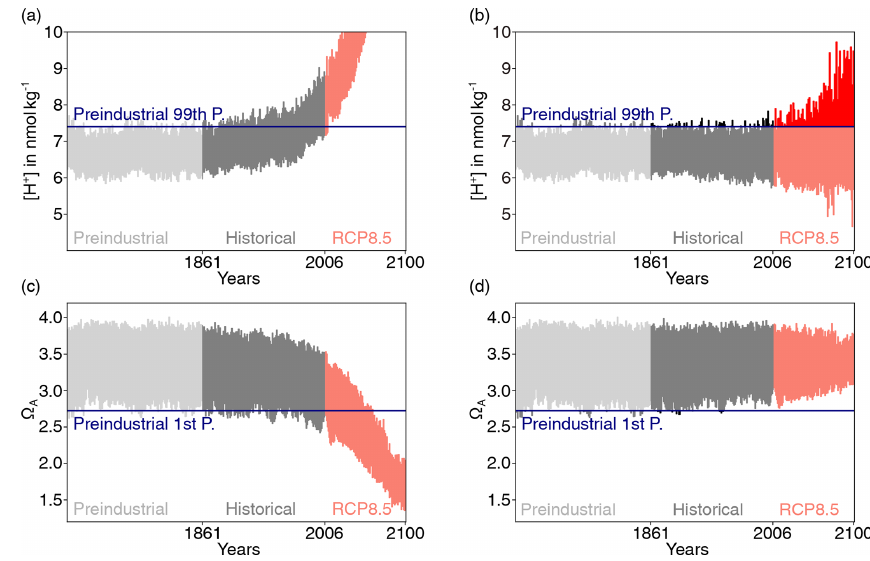
Figure 1. Simulated daily mean surface [H + ] (a) and (cid:127) A (c) at 40 ◦ N and 30 ◦ W in the North Atlantic for one ensemble member over the preindustrial period, the 1861–2005 historical period, and the 2006–2100 period under RCP8.5. The same data as in (a ) and (c) but with subtracted ensemble-mean changes with respect to the average of the 500-year preindustrial control simulation is shown in panels (b) and (d) . For [H + ], the preindustrial 99th percentile threshold (horizontal blue line in panels a and b ) is increasingly exceeded even when subtracting the ensemble-mean change, because [H + ] variability increases. In contrast, a reduction in (cid:127) A variability leads to a reduced undershooting of the preindustrial 1st percentile (d) .